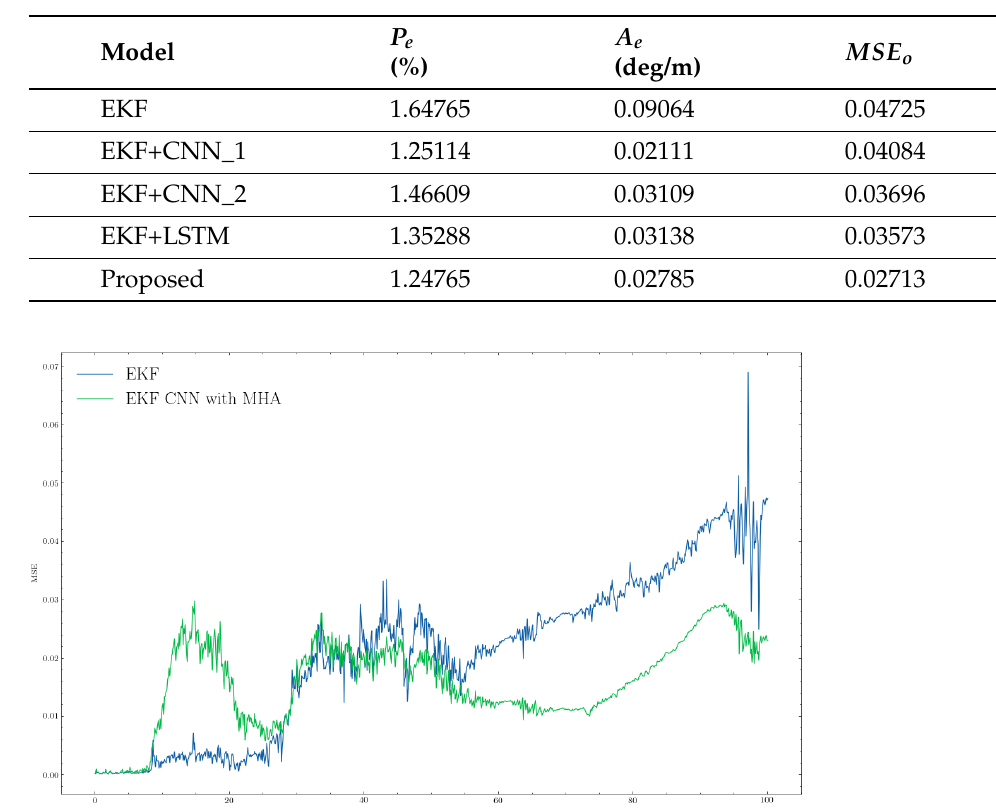
Figure 7. The Mean Squared Error (MSE) comparison between EKF and EKF+CNN with MHA for trajectory 1. Blue and green lines represent EKF and proposed method, respectively